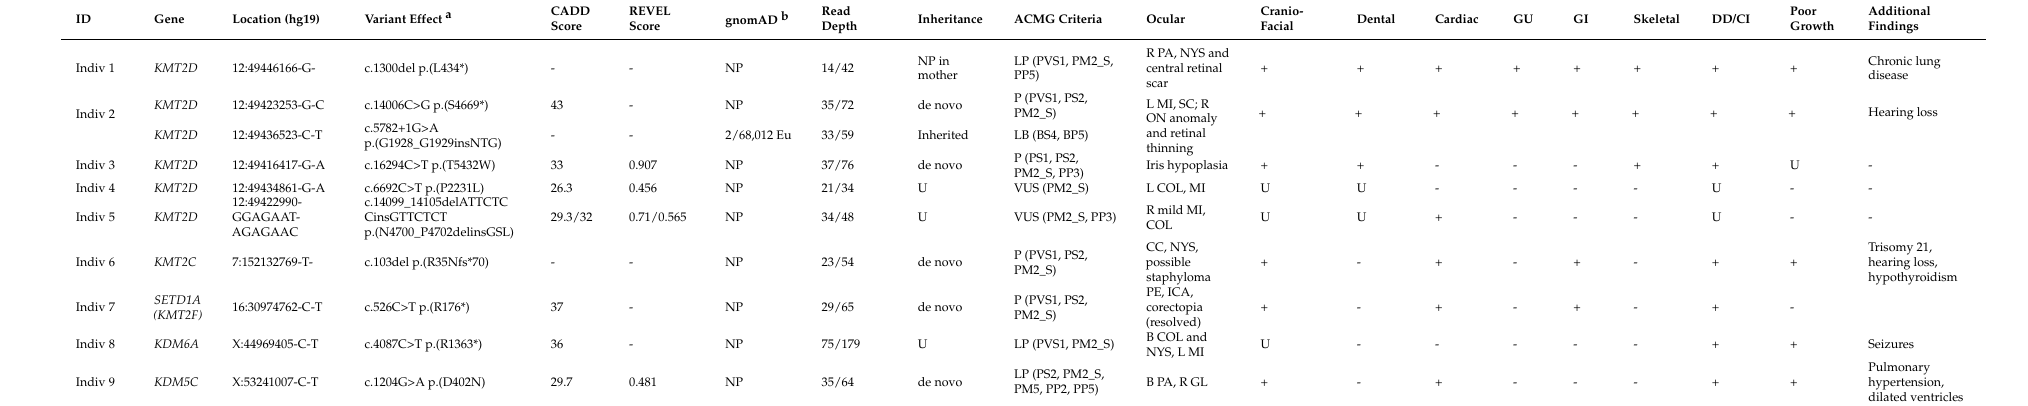
Table 1. Summary of heterozygous genetic variants identified in histone lysine methyltransferase (KMT) and demethylase (KDM)